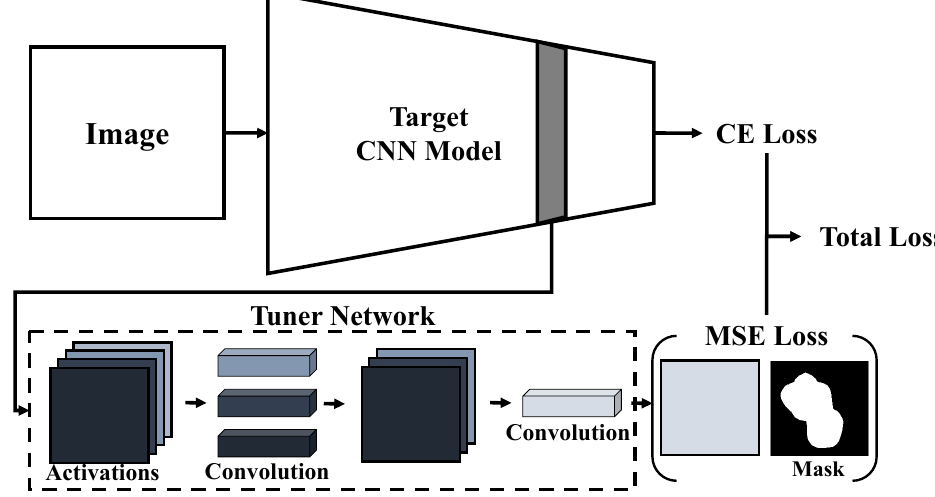
Figure 2. An overview of our activation fine-tuning